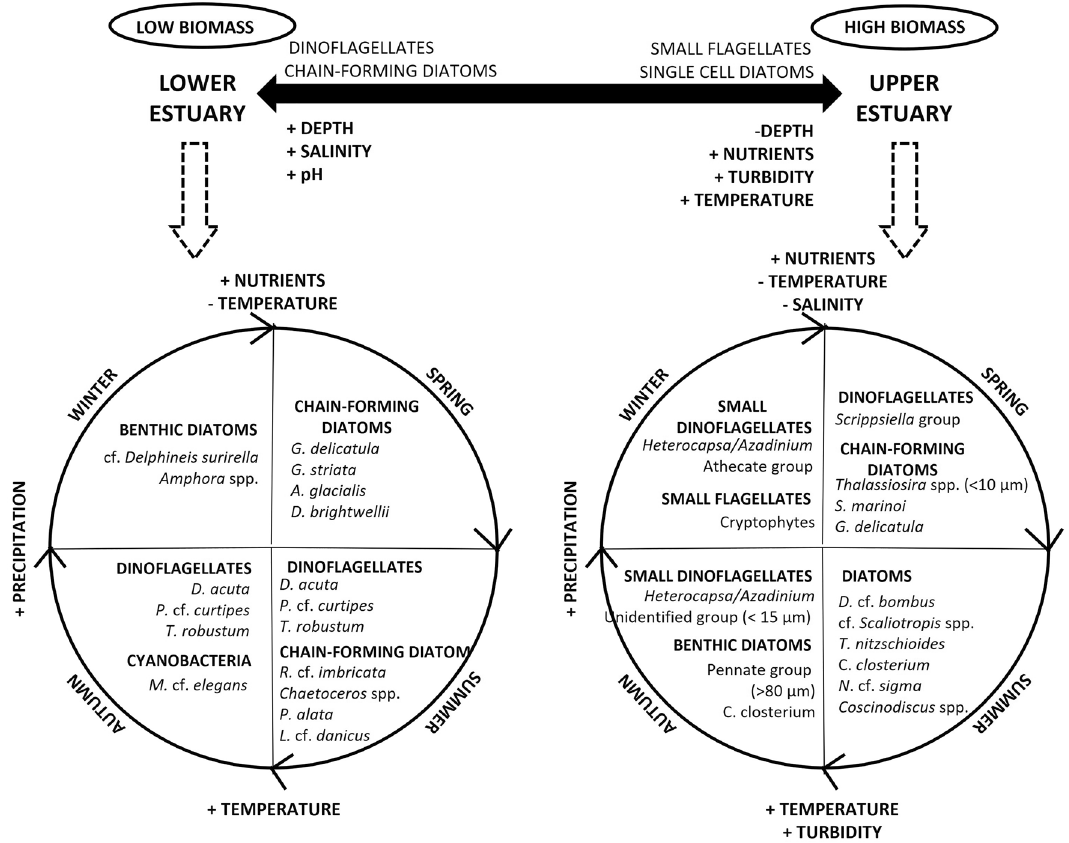
Figure 9. Summary diagram of the dynamics of the phytoplankton community in the Sado Estuary. The main spatial and temporal differences are